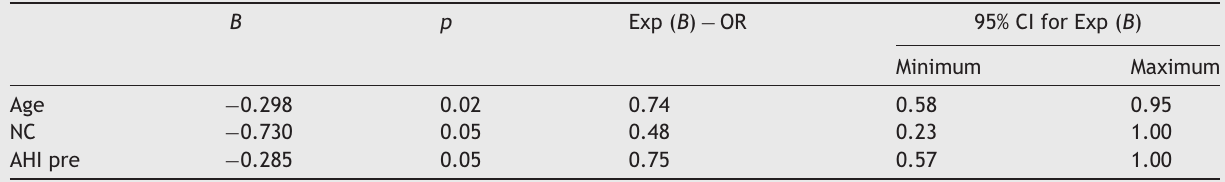
Logistic regression of factors associated with successful treatment with